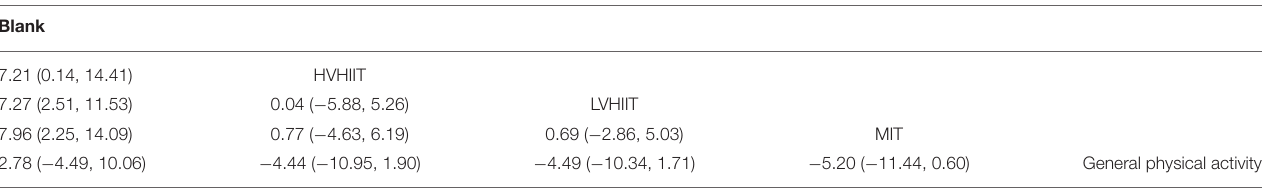
TABLE 2 | The league table of the interventions for systolic blood pressure (SBP).